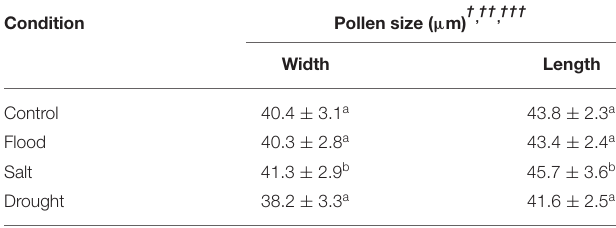
TABLE 2 | Pollen size of rice under each experimental